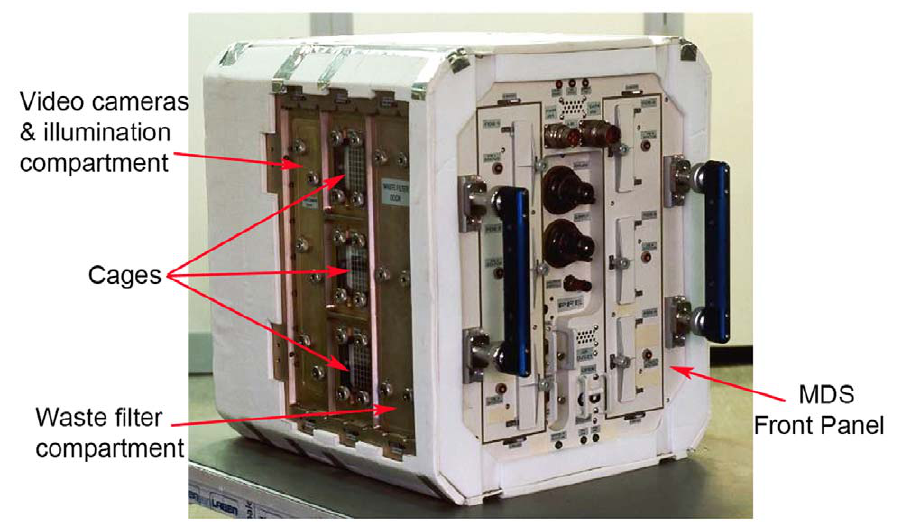
Figure 1. The Mice Drawer System Flight Model.